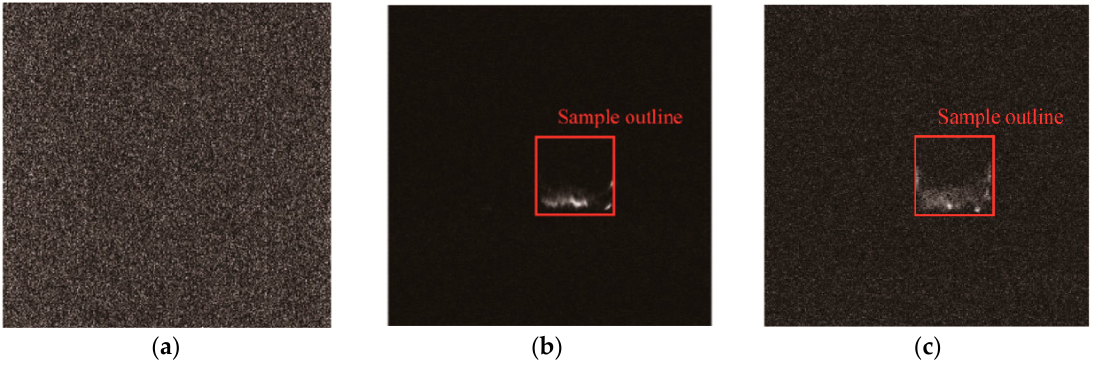
Figure 8. NMR-imaging contrast of sample drying state and saturation state. ( a ) Original dry; ( b ) saturated with silica sol; ( c ) saturated with water.